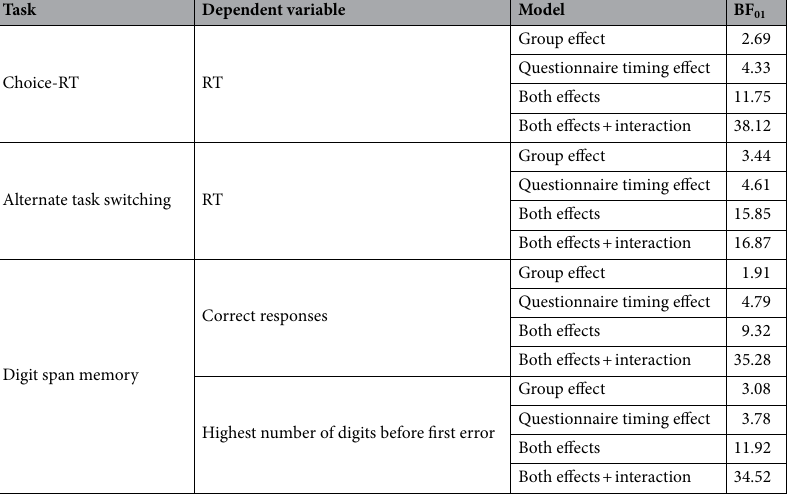
Table 3. Bayes factors (BF 01 ) for the relevant main effects and the interactions that were insignificant in null hypothesis significance